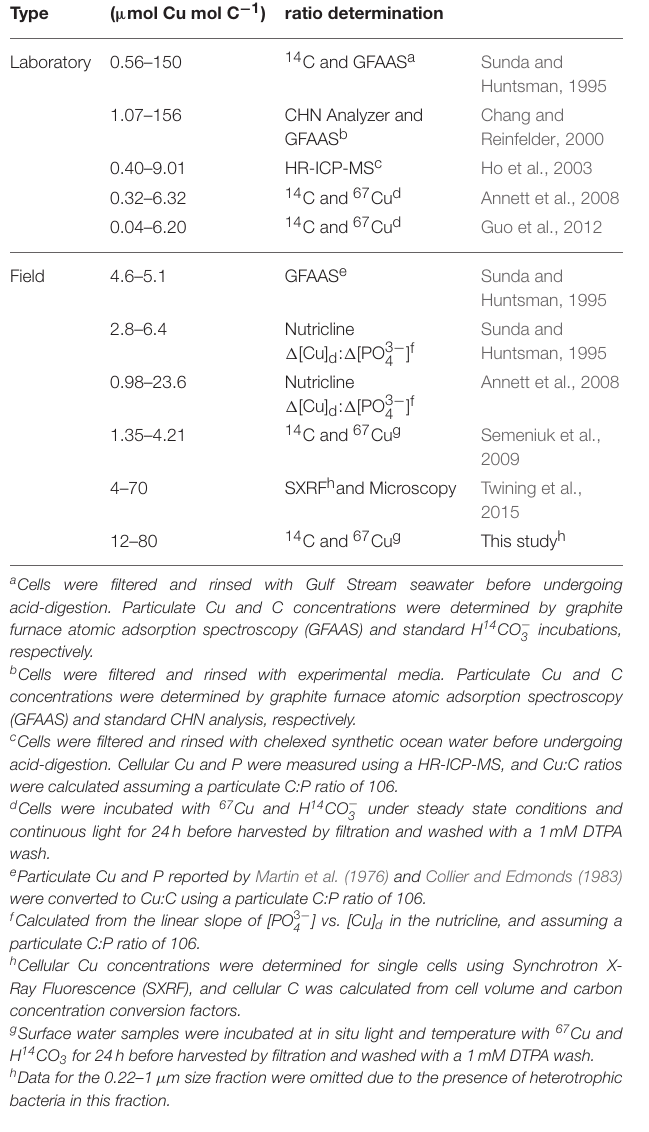
TABLE 7 | Particulate Cu:C ratios in natural phytoplankton communities and laboratory strains grown under Cu-limiting and toxic conditions. Study Cu:C ratio Method of Cu:C